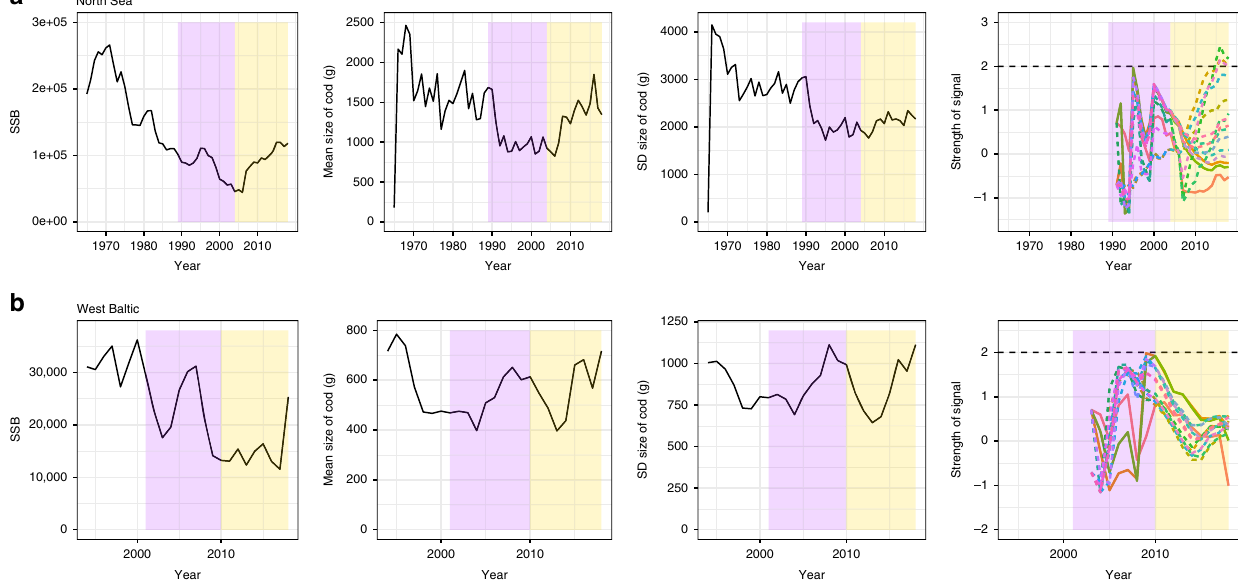
Fig. 8 ICES cod survey data for the North Sea and Western Baltic Sea. Panels show spawning stock biomass (SSB), mean size, and SD size dynamics of the ( a ) North Sea and ( b ) West Baltic Sea cod stocks, as well as the dynamics of the warning signals of recovery. The purple box highlights the training data period used in the warning signal calculation, while the yellow box highlights the period over which warning signals of recovery were searched for (after fi shing pressure has begun to decline, but prior to the population recovering). Warning signals of recovery are considered as present when the lines exceed a 2 σ threshold (horizontal black dashed lines). Solid lines show metrics which do not include some measure of size, dashed lines indicate a metric includes either mean size or SD size or